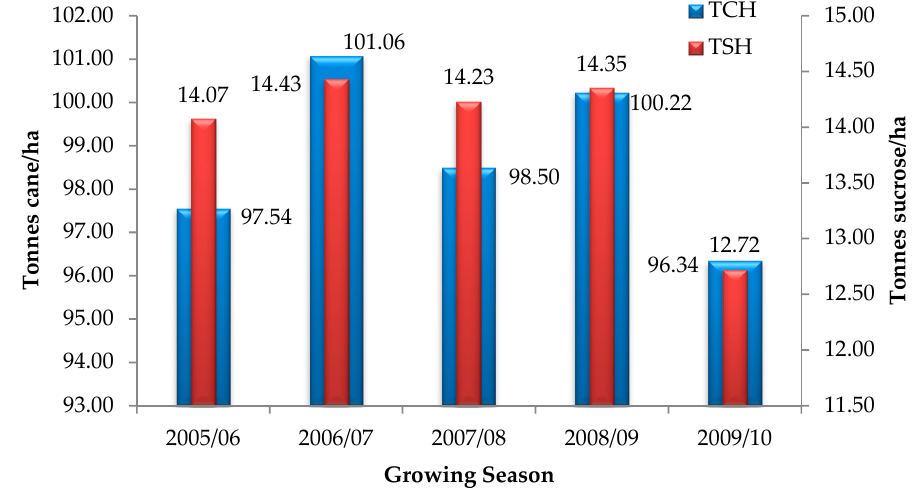
Figure 3. Sugarcane yield in tones sucrose per hectare (TSH) and tones cane per hectare (TCH)